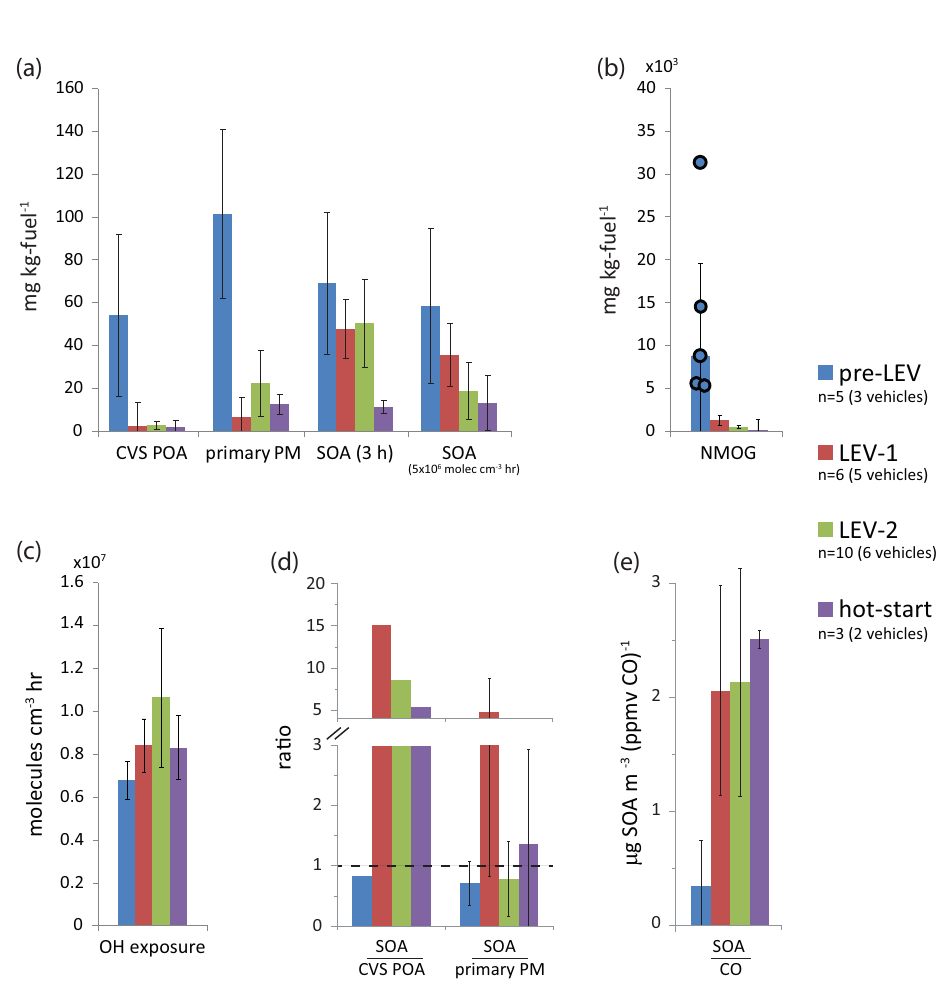
Figure 6. Primary emissions and chamber data for hot- and cold-start UC chamber experiments with vehicles from the three LEV classes. (a) Median POA, primary PM (primary PM was not measured for LEV2-3.1), and (b) NMOG emissions measured in the CVS (filled circles represent individual measurements). Median SOA production (a) during 21 cold-start UC chamber experiments after 3h of photooxidation (“SOA (3h)”) and after 5 × 10 6 moleculescm − 3 h of OH exposure (LEV1-2.1 and high-emitter (LEV1-6) outliers were removed). (c) Median OH exposures after 3h of photooxidation. (d) Median ratios of SOA to primary PM and SOA to POA after 5 × 10 6 moleculescm − 3 h of OH exposure. The dashed horizontal line in (d) represents 1:1. (e) Median ratios of SOA (5 × 10 6 moleculescm − 3 h of OH exposure) to CO. Error bars represent uncertainty/variability propagated through all measured variables. Only one experiment is shown (no error bar) for the hot-start SOA-to-POA ratio. Error bars for other SOA-to-POA ratios are not included; they are large due to several experiments with extremely low POA